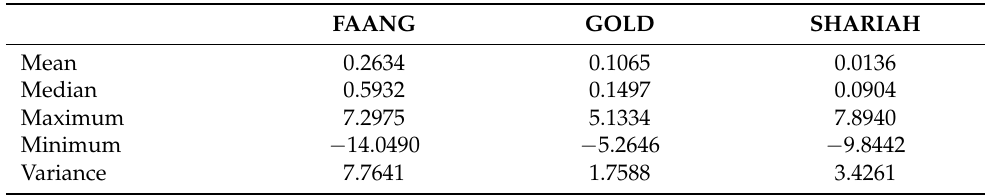
Table 1. Summary statistics for daily